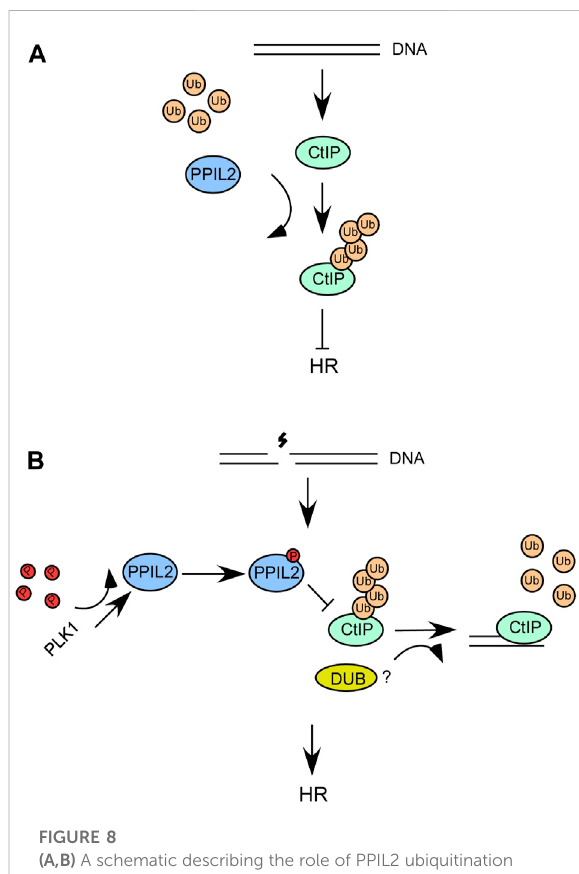
FIGURE 8 (A,B) A schematic describing the role of PPIL2 ubiquitination of CtIP and how it affects HR and DSB end